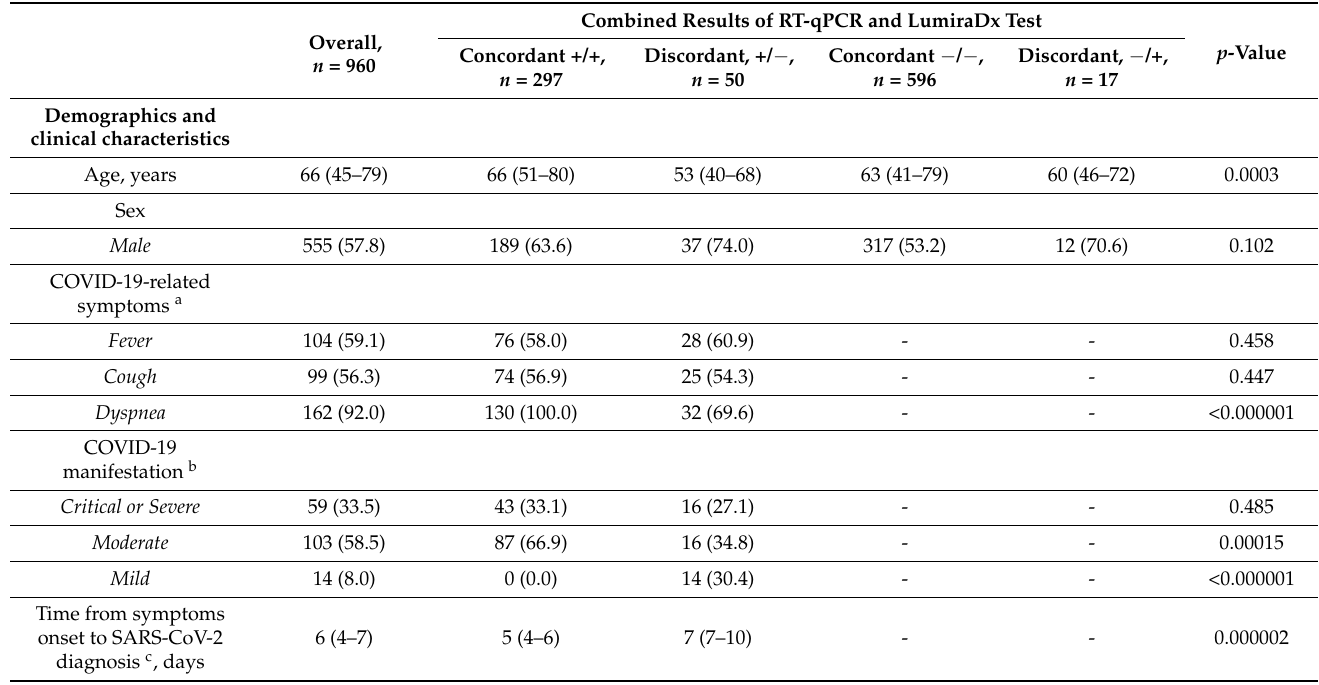
Table 1. Demographic, clinical, and virological characteristics of the 960 individuals simultaneously screened for SARS- CoV-2 infection by LumiraDx test for the nucleocapsid antigen and RT-qPCR.